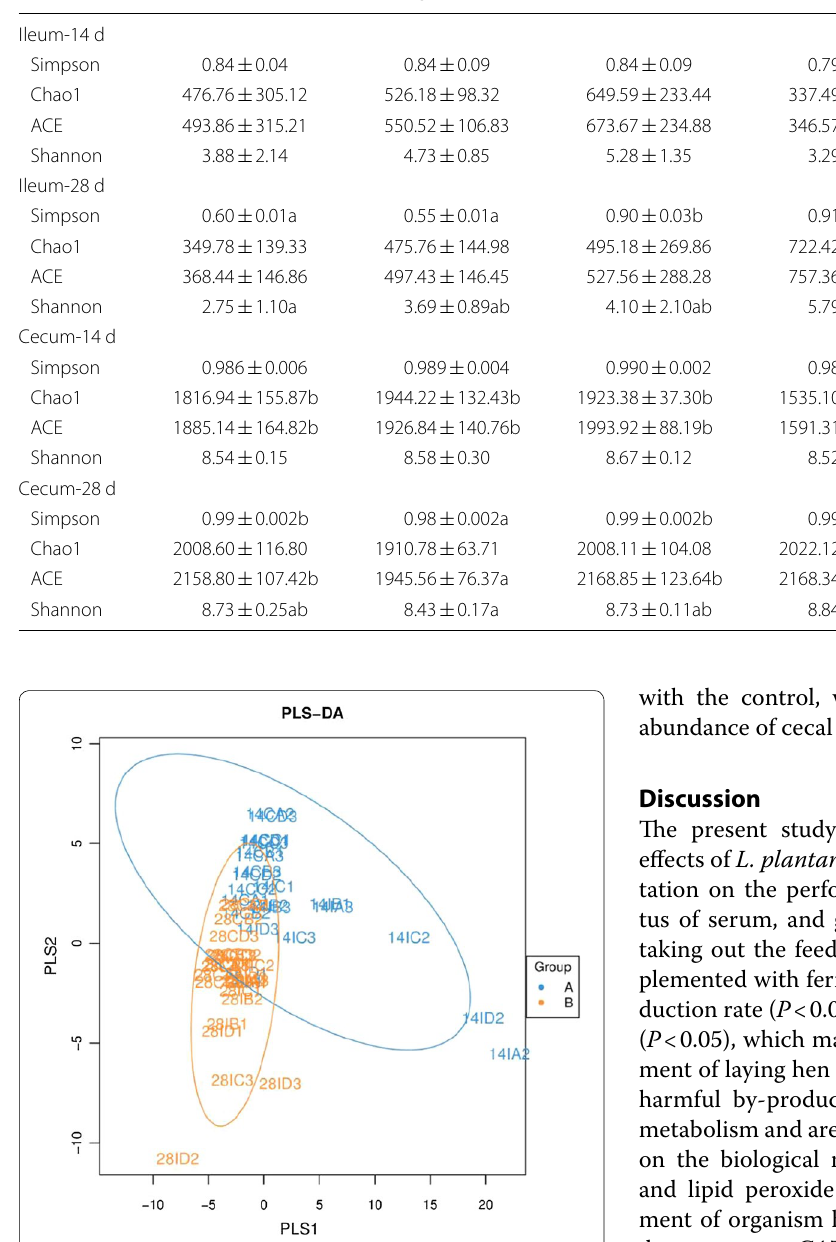
Table 6 α-diversity indices of ileum and cecum on days 14 and 28 Parameters